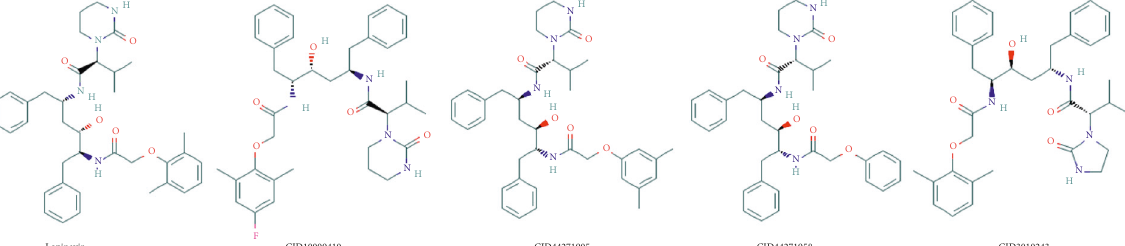
Figure 1: The chemical structures of lopinavir and lopinavir analogs [29].